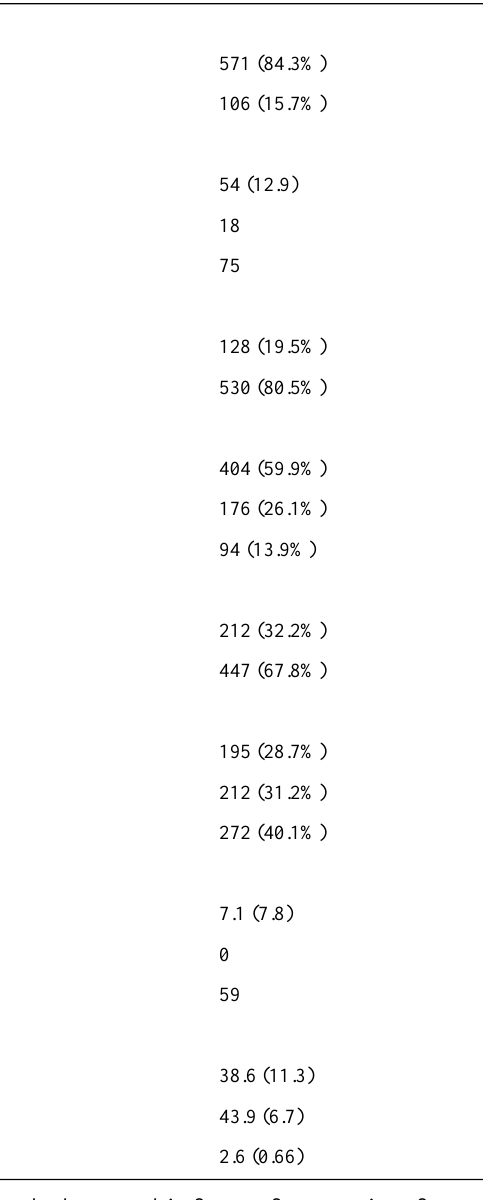
Table 1. Demographic and health characteristics of the participants and social support factors (602 ≤ n ≤ 679)